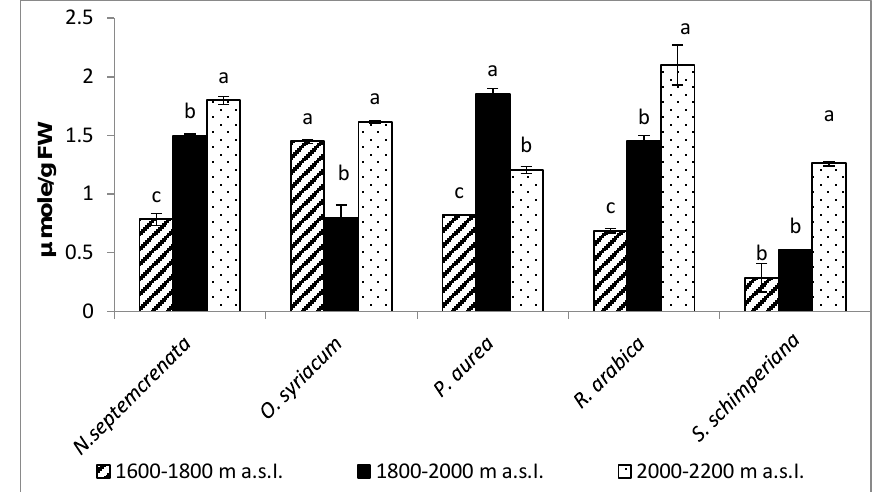
Figure 9. Change in contents of ascorbic acid of different five plant species grown at different altitudes of SKP mountains. Each value is the mean of three replicates ± SE. Bars with different letters are significantly different at p ≤ 0.05.